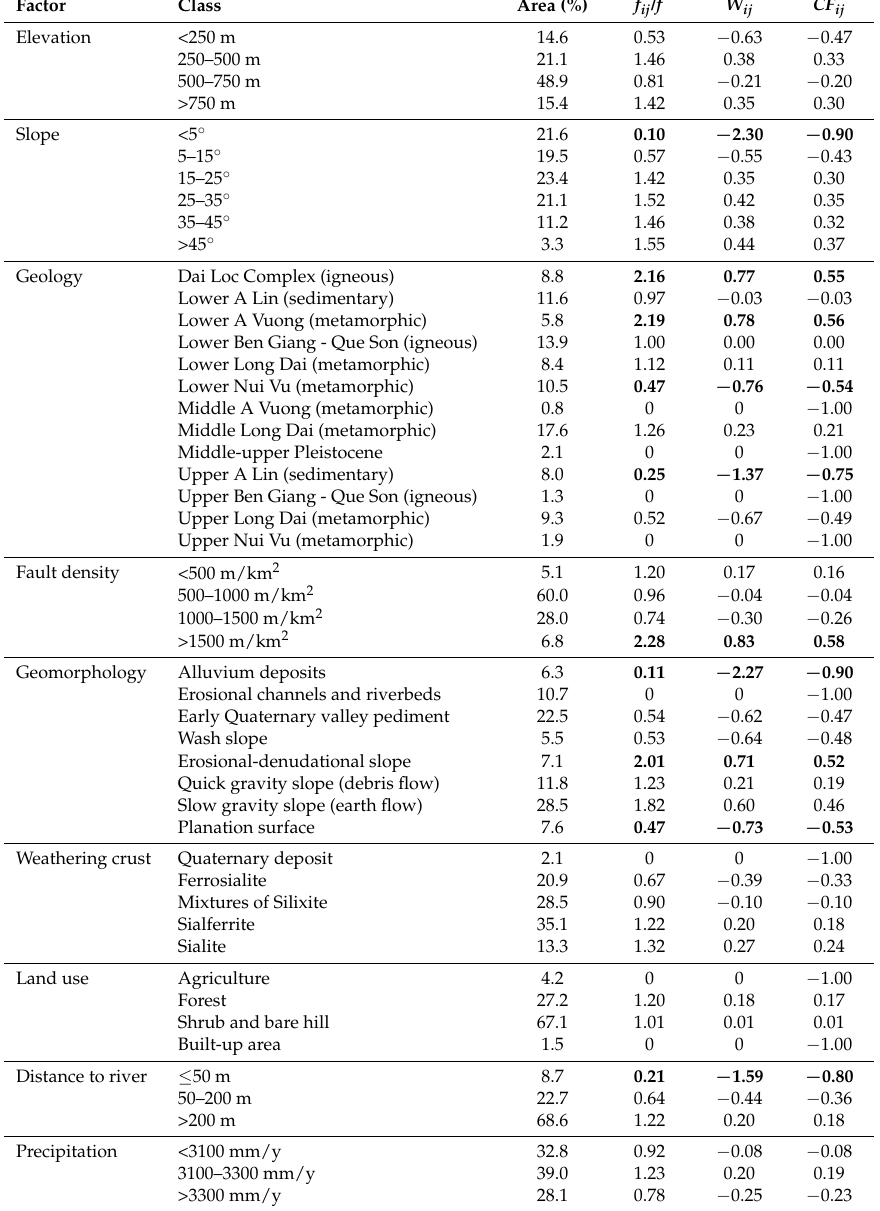
Table 1. Causative factors for landslide, classes in each factor, and associated area ratios, landslide frequency ratios, SI weights and CF values (significant values are indicated in